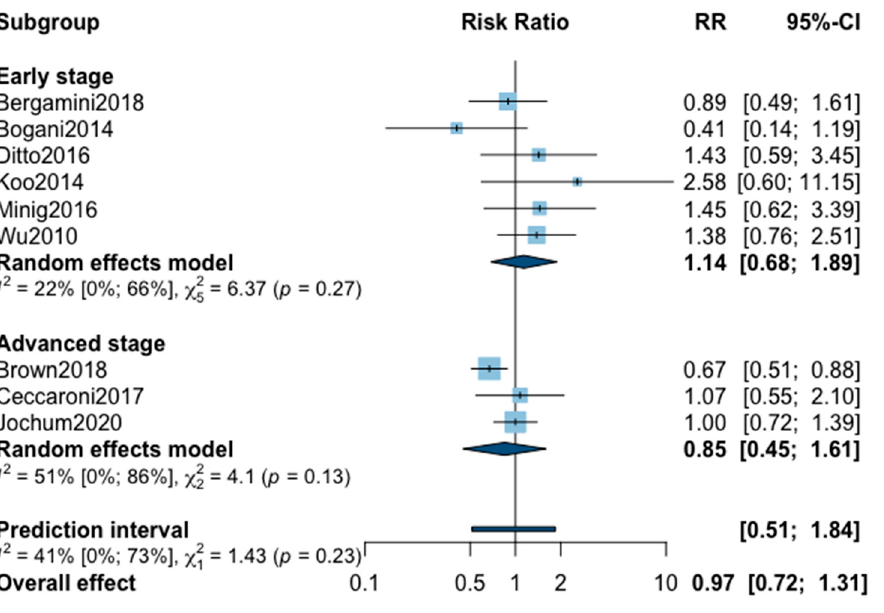
Figure A1. Meta-analysis for five-year recurrence.